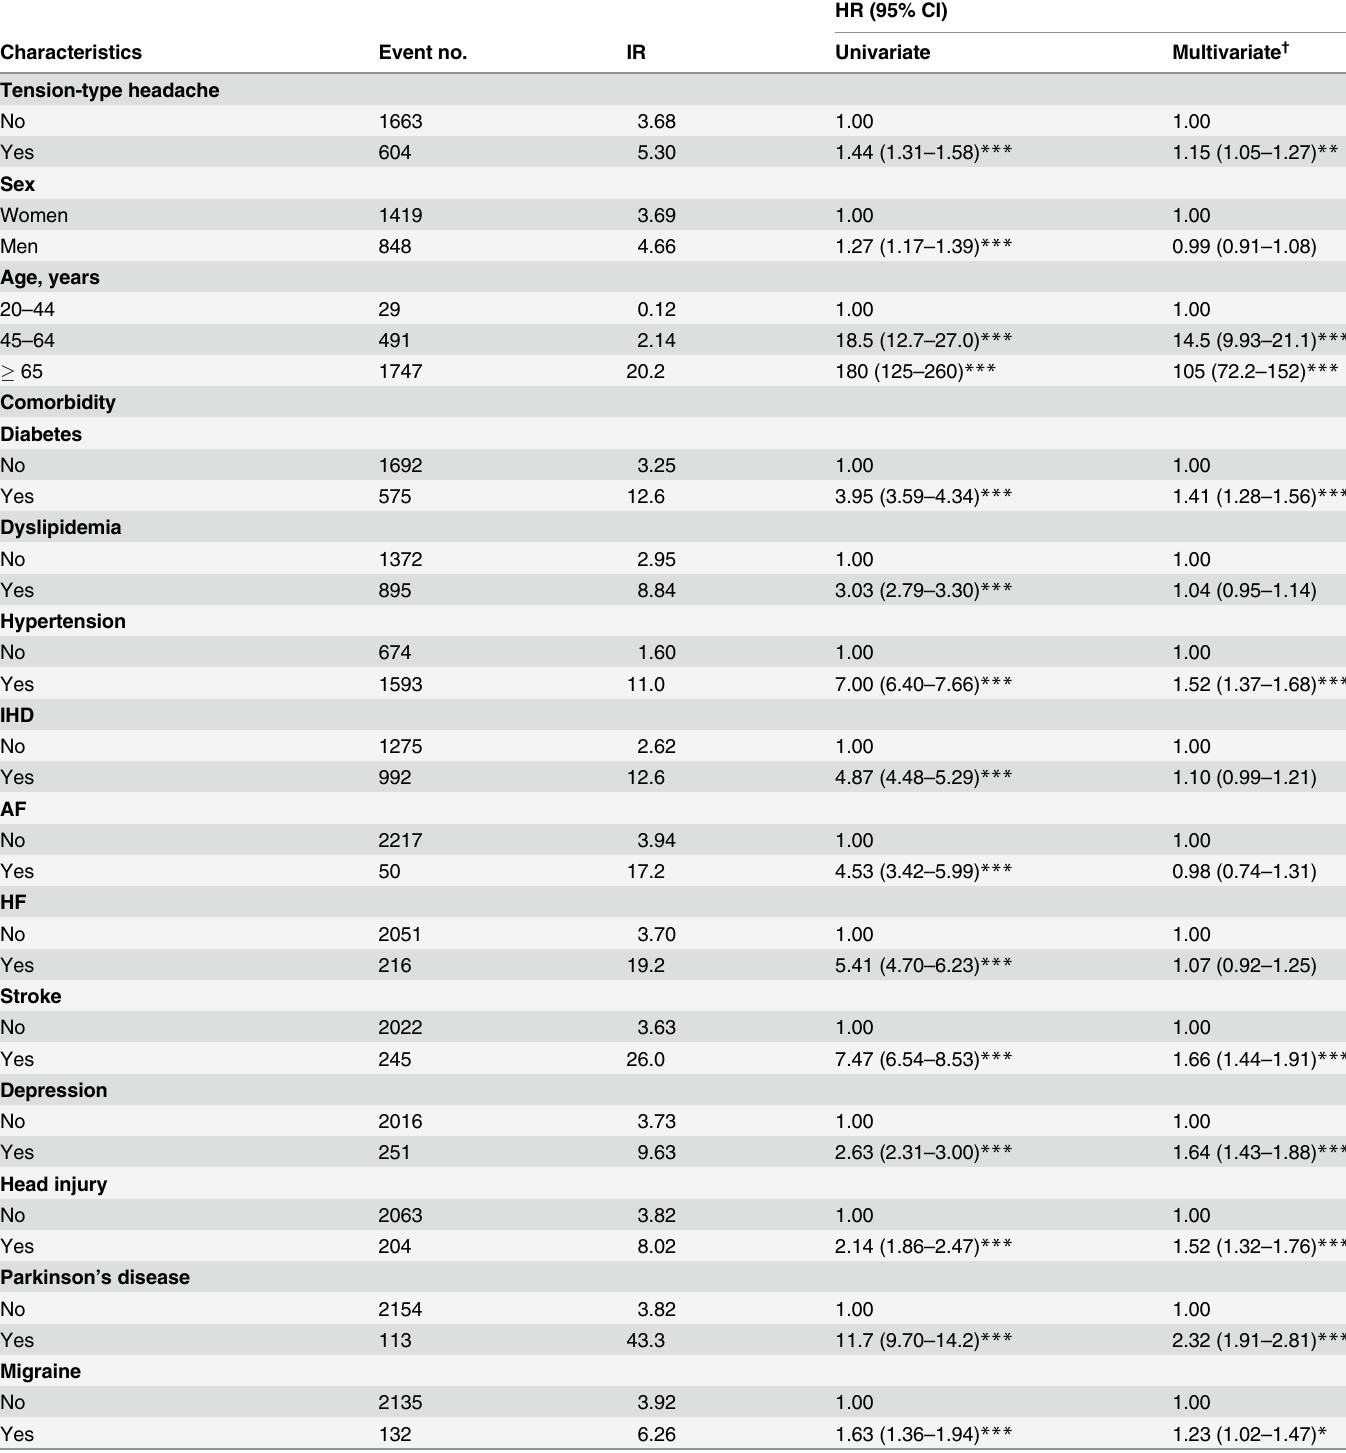
Table 2. Cox model measured hazard ratios and 95% confidence interval of dementia associated with tension-type headache and covariates.